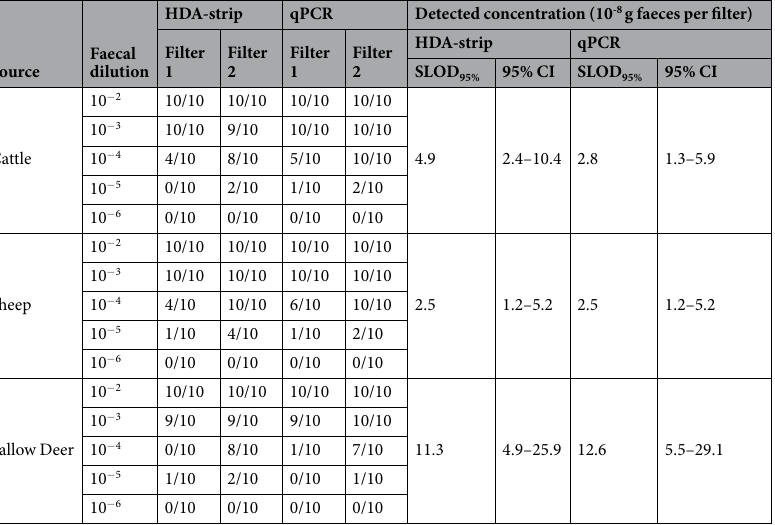
Table 2. Sample limit of detection experiments with the HDA-strip and qPCR method. The results are given as the number of positive replicates from the analyses of 10 replicates per faecal dilution step. The total number of replicates from both filtrations (i.e., n = 20 replicates per faecal dilution) served as input for statistical analysis. Detection limits were calculated as the minimum amount of faeces detectable in a filtration volume at a 95% detection probability (SLOD 95% ) with a 95% confidence interval